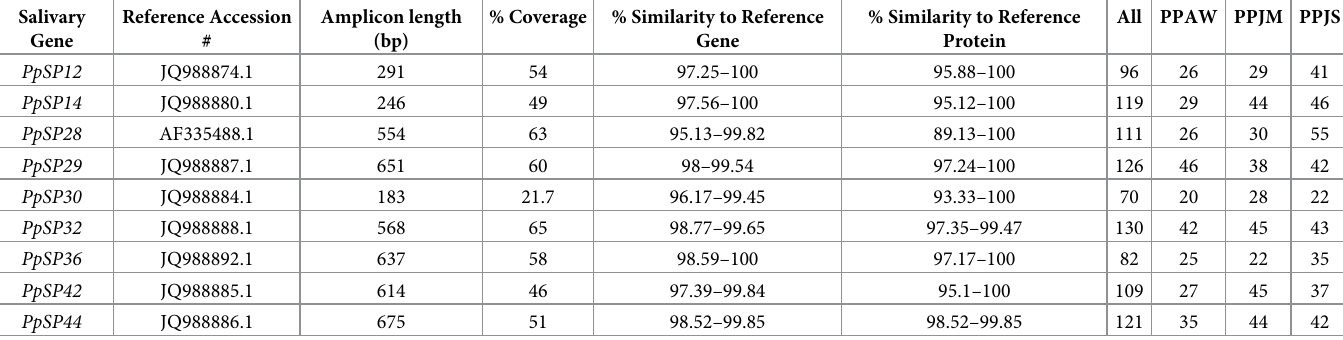
Table 1. Phlebotomus papatasi salivary transcript amplicon length and number of individual sand flies per collection site. Salivary